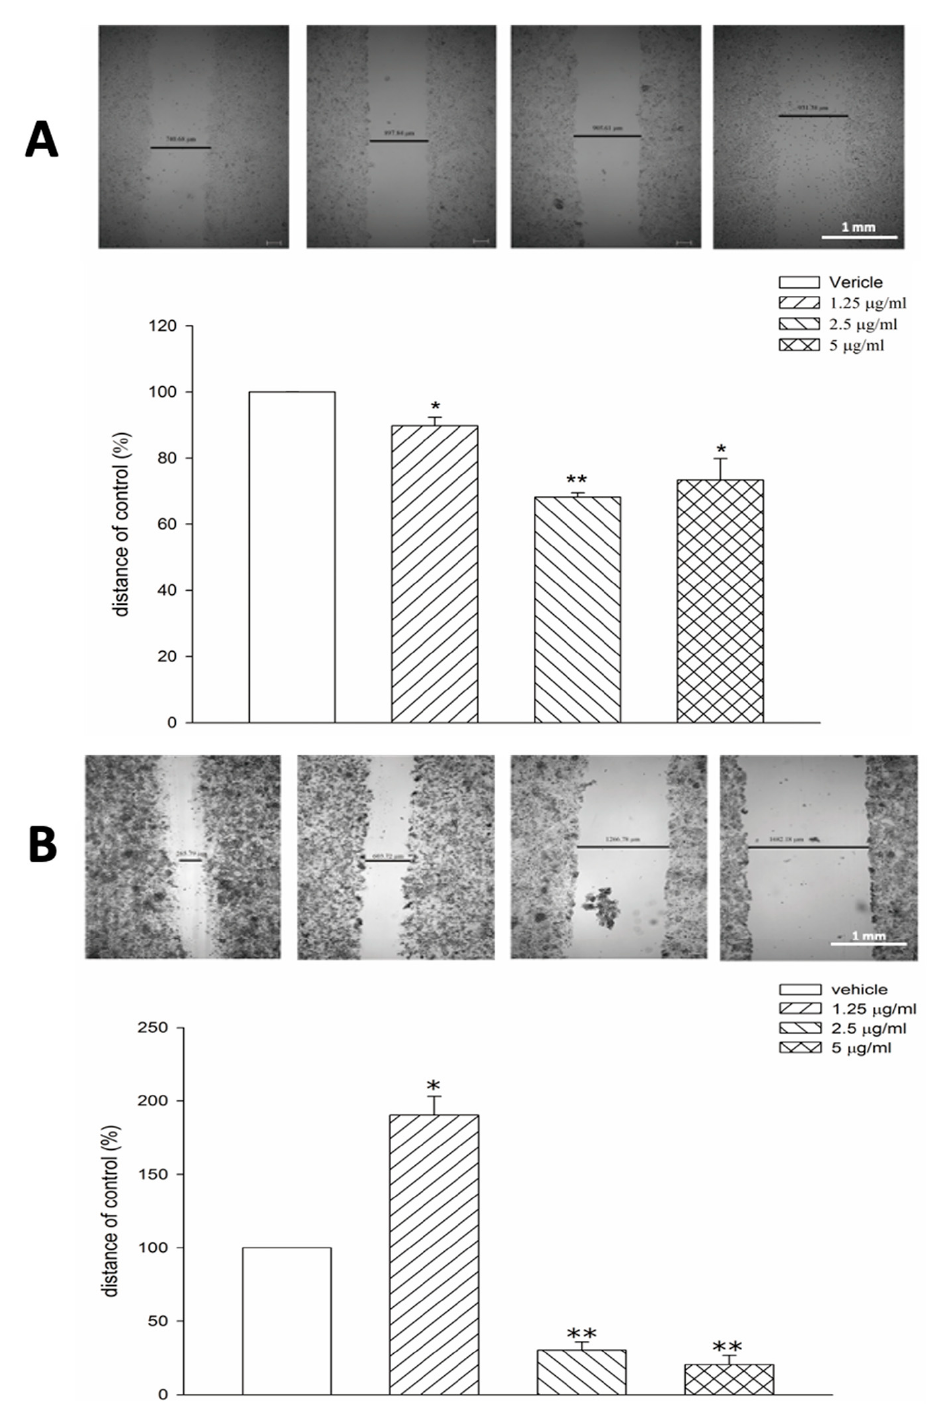
Figure 3. Tagitinin C inhibits cell migration of Hep-G2 and Huh 7 cells. ( A ) Scratch migration assay of Hep-G2 cells (control or tagitinin C-treated cells). ( B ) Scratch migration assay of Huh 7 cells (control or tagitinin C-treated cells). * p < 0.05 vs. control, ** p < 0.01 vs. control.